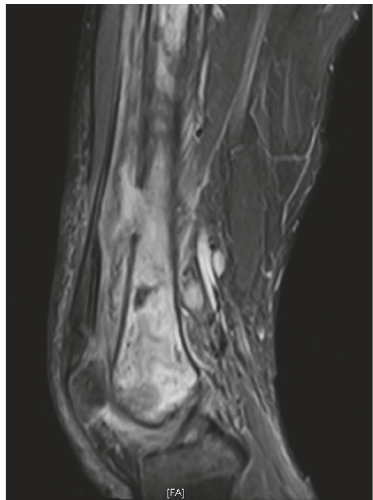
Figure2:SagittalMRIofrightkneewithchronicosteomyelitisfrom distal femur diaphysis to most distal aspect.